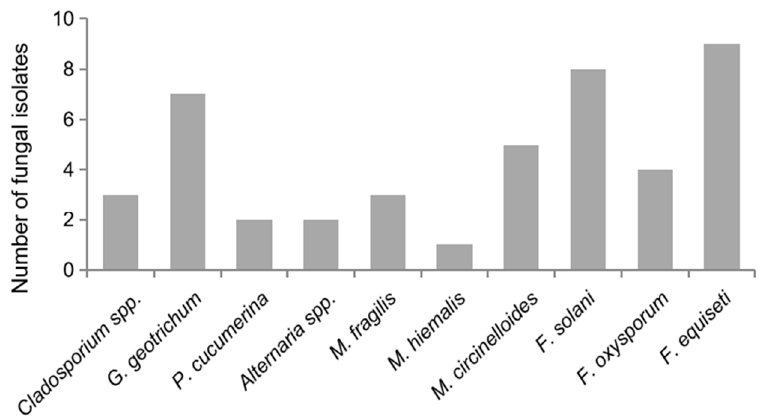
Figure 2. Fungal isolates from rotten gherkins. Forty-four fungal isolates obtained from rotting gherkins were analyzed by sequence data and morphological determination. The following species were identified: Fusarium equiseti , Fusarium oxysporum , Fusarium solani , Mucor hiemalis , Mucor fragilis , Mucor circinelloides , Galactomyces geotrichum , and Plectosphaerella cucumerina , while isolates identified as Alternaria sp. and Cladosporium sp. could not be determined more specifically.